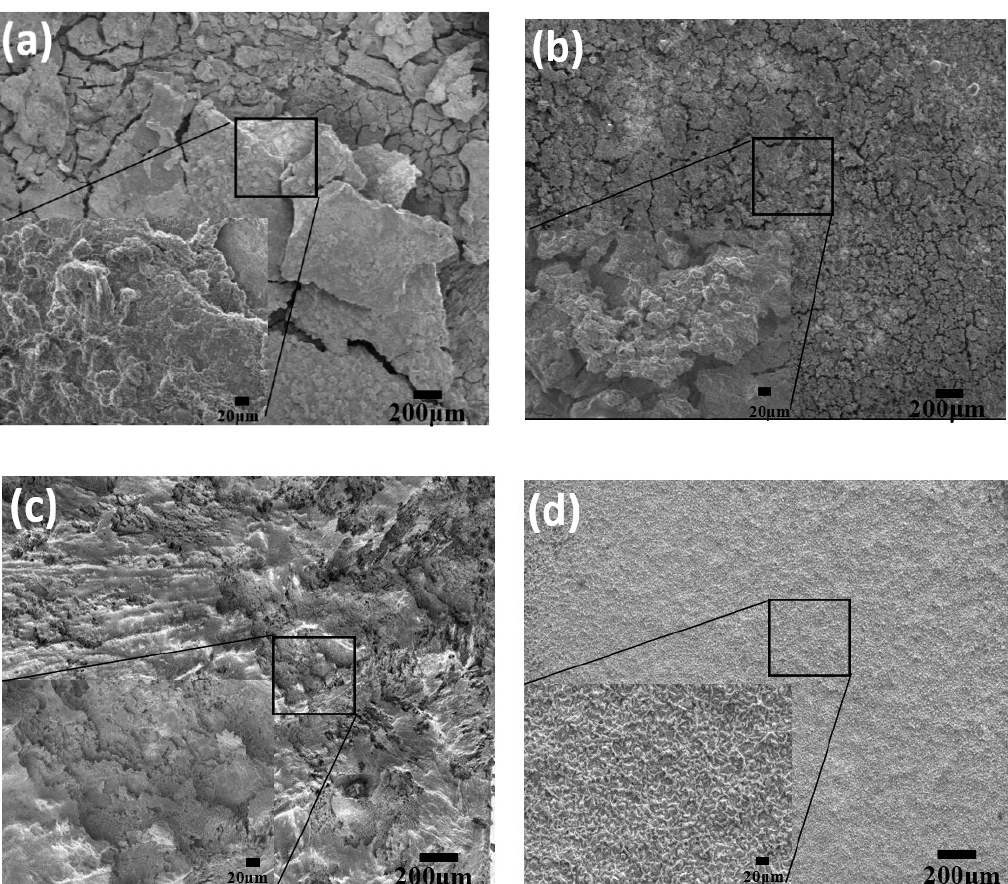
Figure 6. SEM images of ( a ) Mg and ( b ) Mg–8%Al–0.4%Bi discharged at 120 mA/cm 2 for 20 min